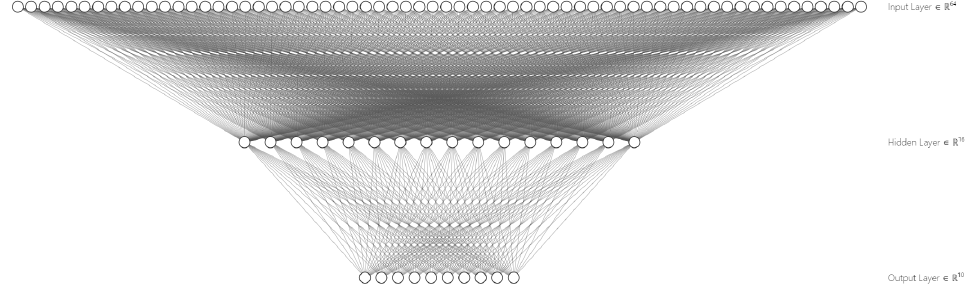
Figure 5. Graphical representation of the MLP neural network of scenario 2.